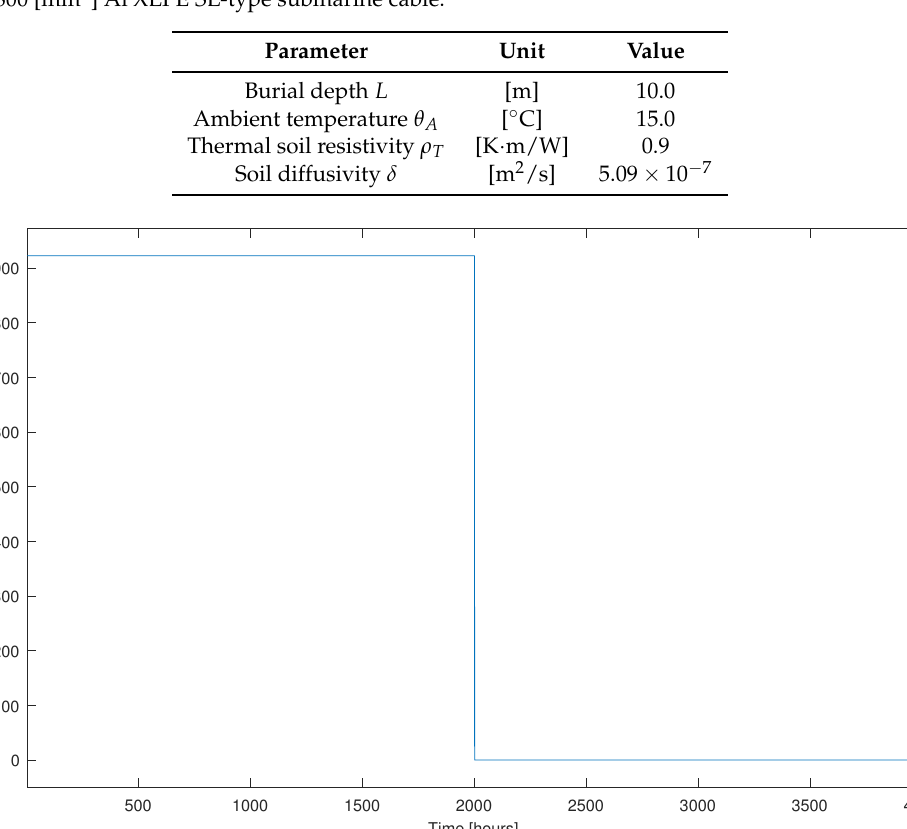
Figure A1. Full-load no-load current step for COMSOL Multiphysics FEM validation of a 220 [kV] 3 × 1800 [mm 2 ] Al XLPE SL-type submarine